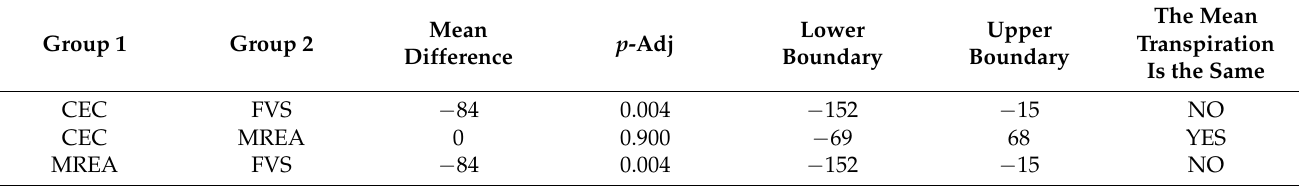
Table 2. ANOVA and Tukey test results showing the difference between the transpiration estimated based on different methods (CEC, MREA, and FVS). The null hypothesis is that the mean transpiration between different groups is the same (shown in the last column). “Mean difference” is the mean difference between “Group 1” and “Group 2.” “Lower boundary” and “Upper boundary” are the lower and upper 95% confidence interval boundaries, respectively. The unit for “Mean difference,” “Lower boundary,” and “Upper boundary” is Wm − 2 .